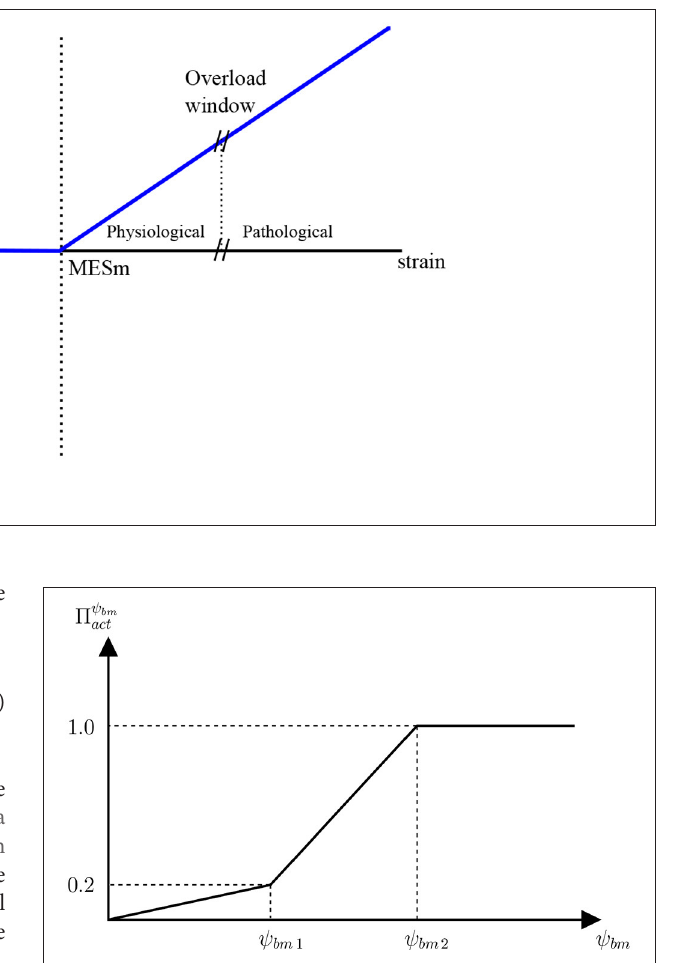
FIGURE 3 | Function of proliferation of osteoblasts precursors that establishes the relation between the anabolic factor 5 ψ bm act and the SED.